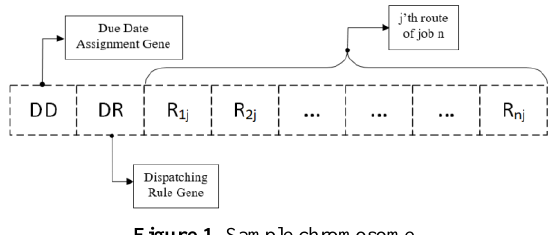
Figure 1. Sample chromosome.